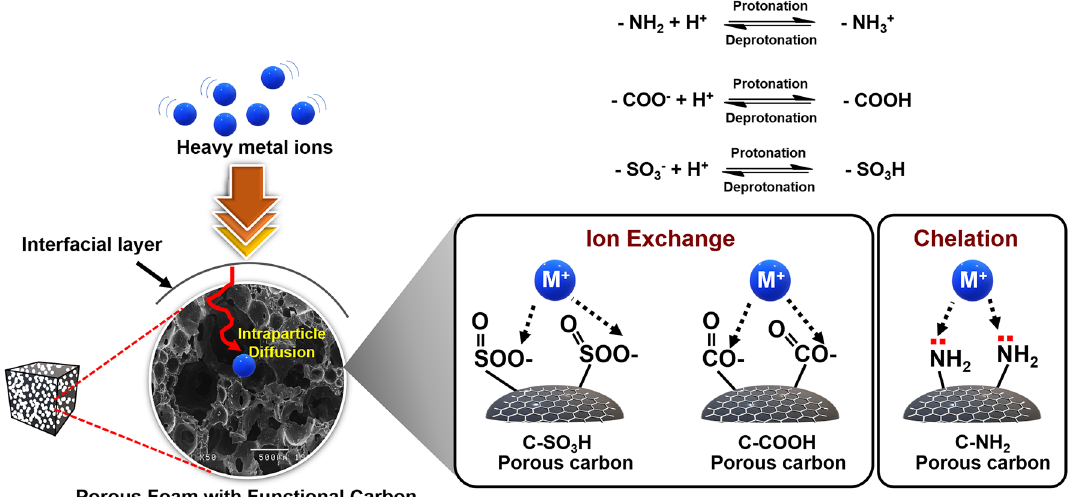
Figure 6. Proposed mechanism of heavy metal adsorption in the functionalised carbon